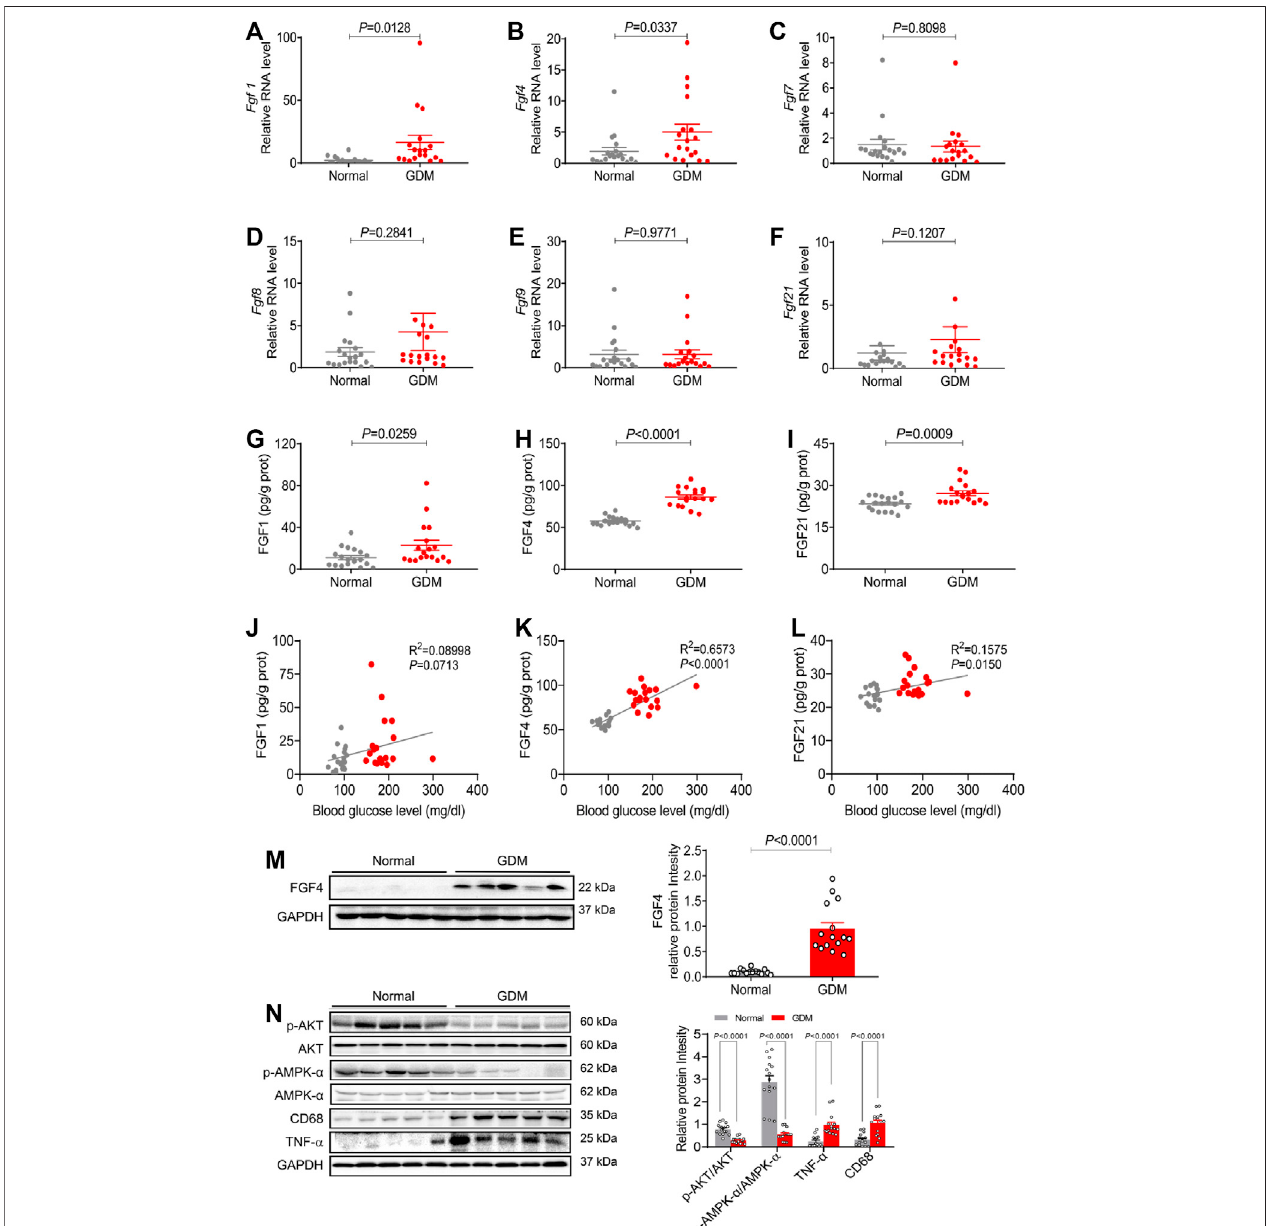
detected using ELISA analysis. (J-L) The correlation between growth factors (FGF1, FGF4, and FGF21) and blood glucose. Data are presented as mean values ±SEM ( n = 18 – 19); (M,N) Protein levels of FGF4, phosphorylation of AKT (p-AKT), p-AMPK/AMPK, CD68 and TNF- α in human placentas were detected using western blotting. Data are presented as mean values ±SEM ( n = 15); a value of p < 0.05 was considered to be statistically signi fi